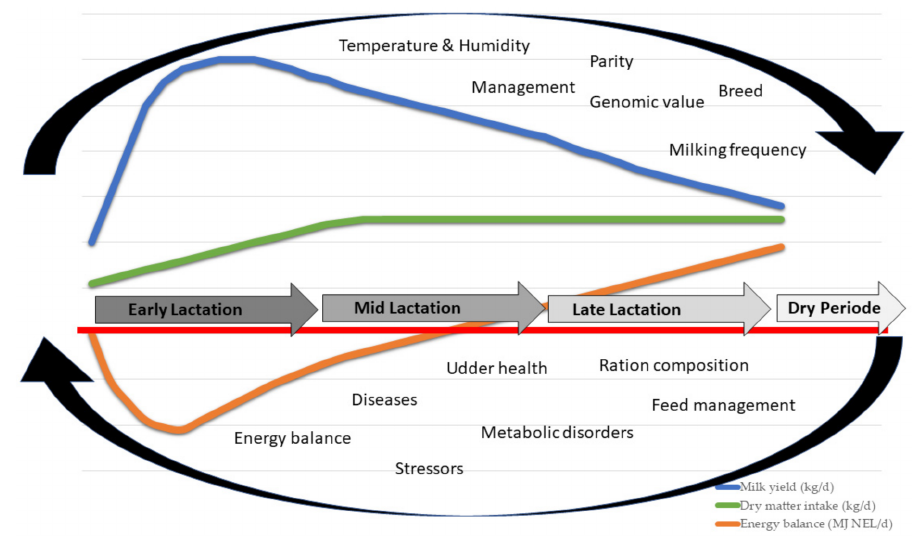
Figure 1. Schematic representation of factors affecting milk yield, dry matter intake and energy balance of dairy cows during different states of lactation